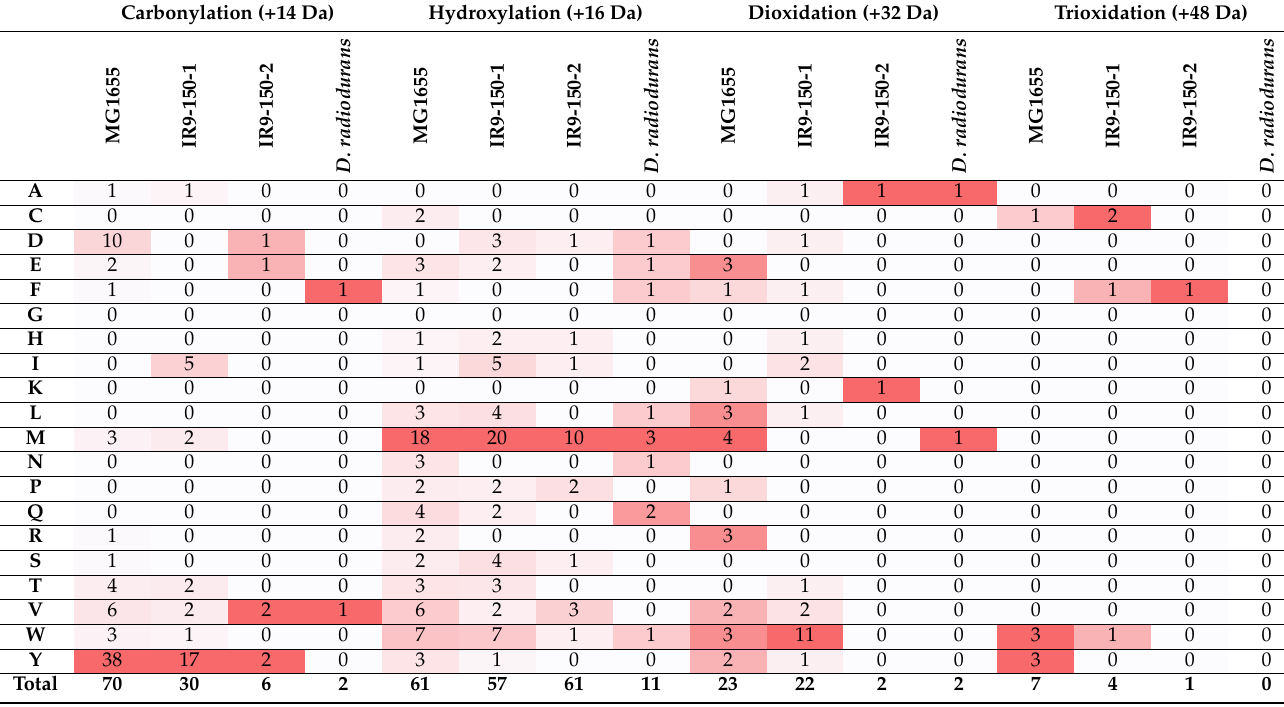
Table 7. Amino acid modifications on peptides exhibiting a decrease in